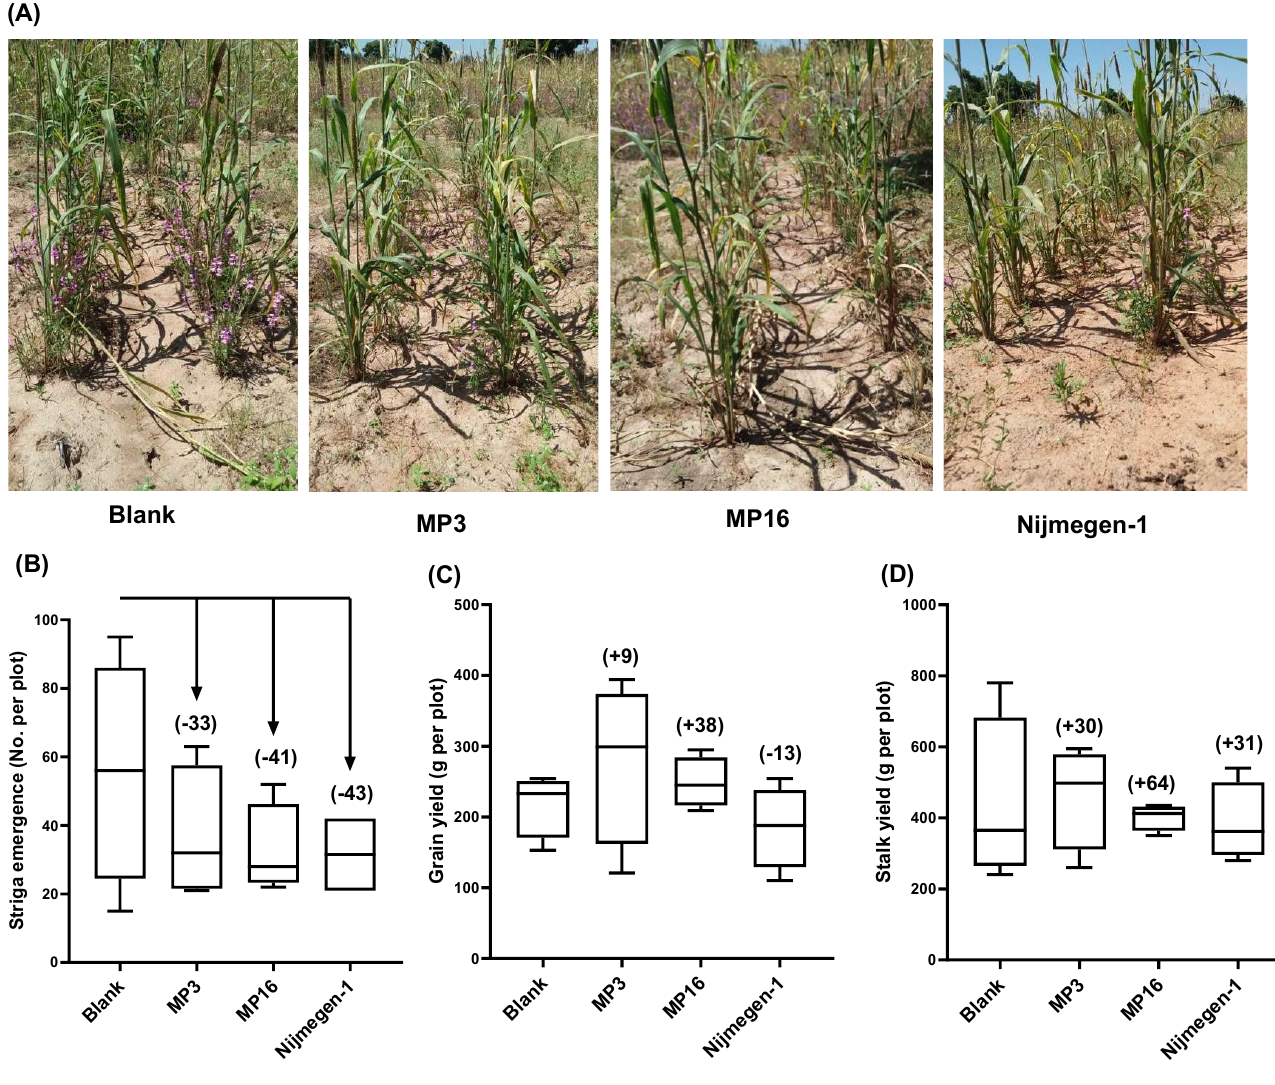
Figure 4. Striga emergence in response to different SL analogs for a naturally infested pearl millet field in Burkina Faso. ( A ) Representative pearl millet plots of farmer’s field, showing Striga emergence under different treatments. ( B ) Number of Striga plants that emerged in pearl millet field under mock, MP3, MP16, or Nijmegen-1 treatment. ( C ) Pearl millet grain yield per plot. ( D ) Pearl millet stalk yield per plot. Data are means ± SE ( n = 4). Values in parenthesis show the percentage increase (+) or decrease (−) over mock treatment.